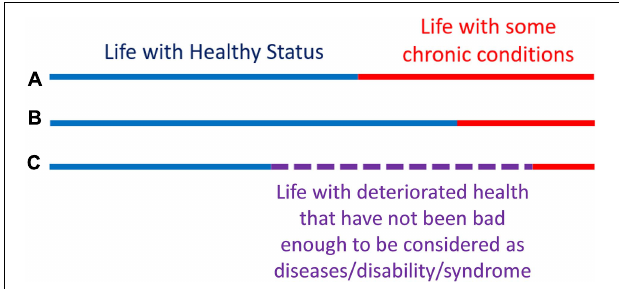
FIGURE 4 | Health-span and life-span. The concept of “health-span” schematically divides life-span into “healthy” and a period of life characterized by chronic conditions and/or physical and cognitive impairment (A,B) . Although this rigid classification is attractive, it fails to recognize that trajectories of health are substantially more complex and periods of deteriorating health and function are interlaced with a period of recovery and relative well-being (C) . Thus, while a definition of health-span would be very useful, it has been difficult to operationalize, and no widely recognized definition is available at this stage.